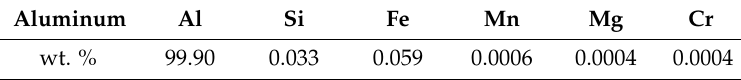
Table 1. Aluminum chemical composition.